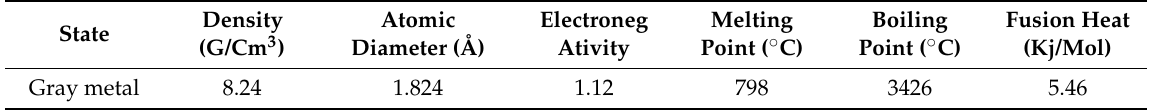
Table 1. Physical properties of cerium